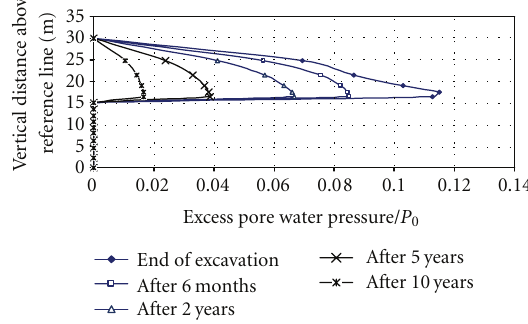
Figure 25: Variation of excess pore water pressure with time along section D-D using MCC soil model.